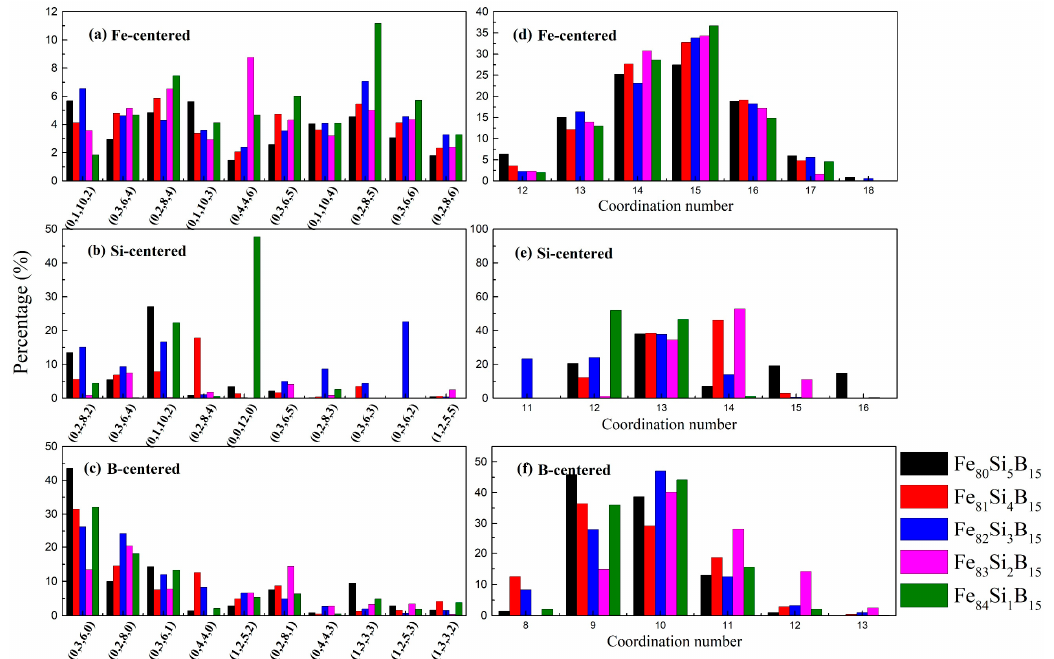
Figure 3. Distributions of typical VP indices for ( a ) Fe-, ( b ) Si-, and ( c ) B-centered clusters and the corresponding distributions of the CNs for ( d ) Fe-, (e) Si-, and ( f ) B-centered in the Fe 80+x Si 5 − x B 15 ( x = 0–4) alloys at 300 K. The VP is defined as the polyhedron with minimum volume constituted by the vertical bisected surfaces between neighboring atoms. Table 2. Fe-centered total and partial CNs in the Fe 80+x Si 5 − x B 15 ( x = 0–4) alloys.